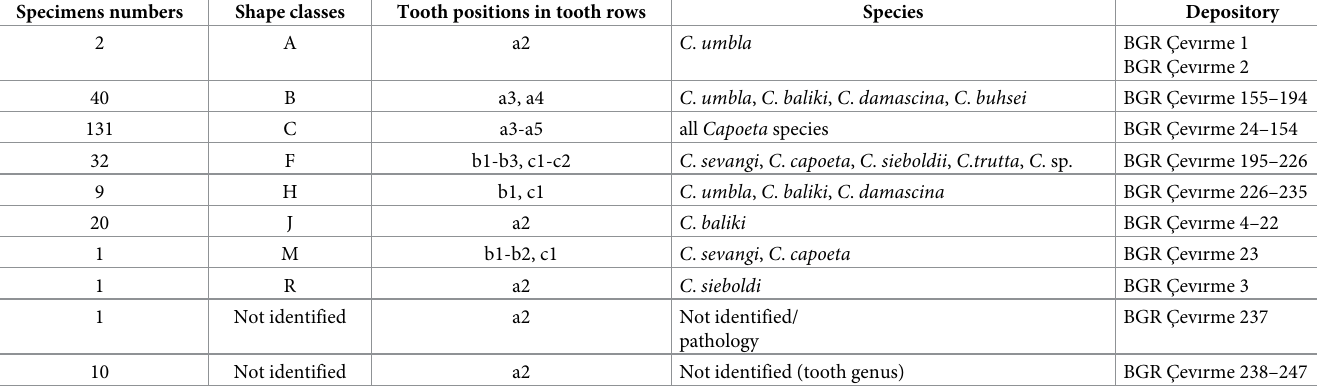
Table 1. Isolated fossil pharyngeal teeth (n = 247) and identified shape classes in the studied fossil